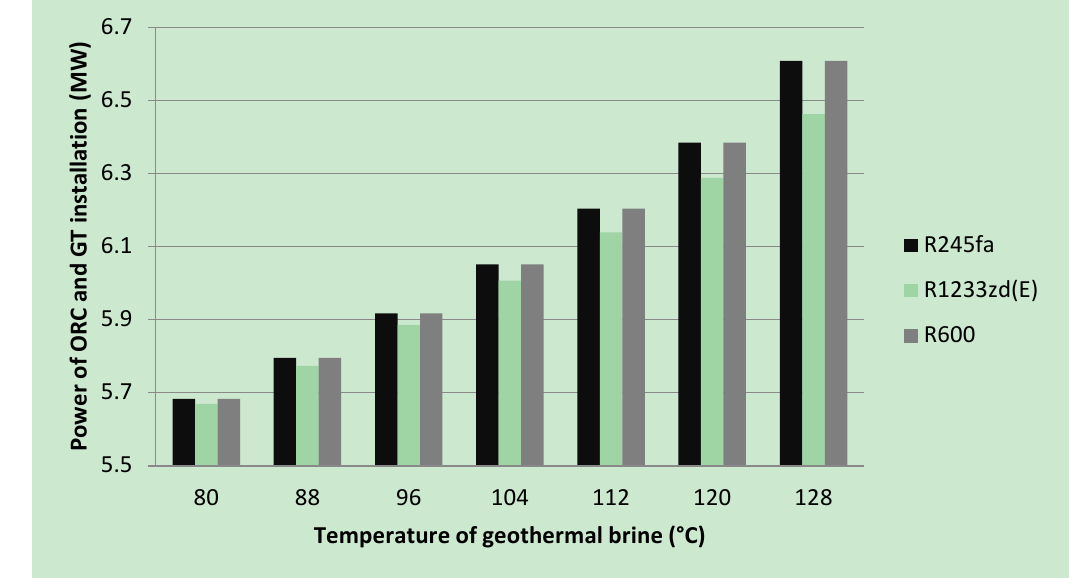
Figure 4. The power of the modified ORC system (assisted by gas turbine) as a function of the geothermal brine temperature.